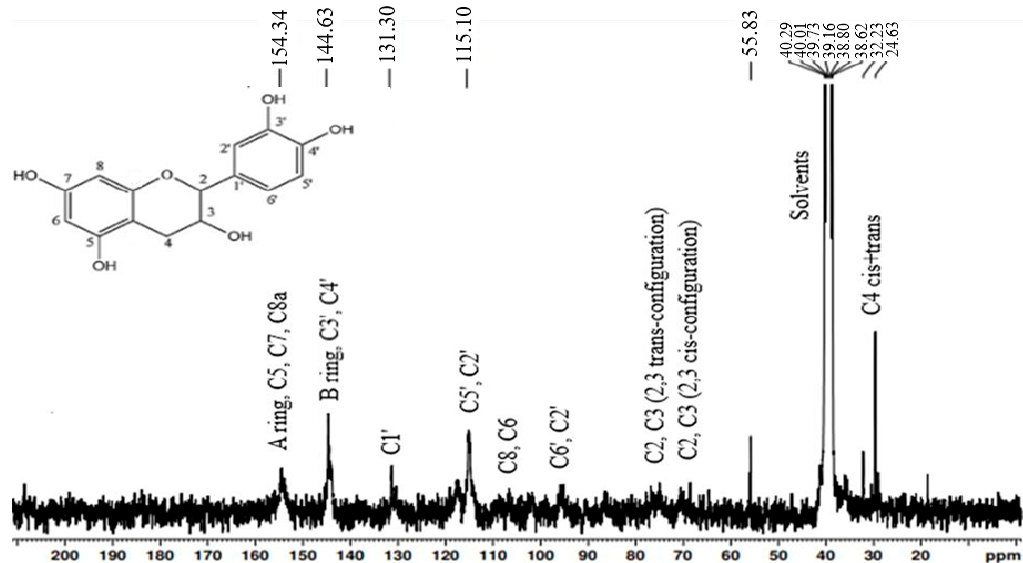
Figure 5. The 13 C-NMR spectrum of purified CTs from Alnus glutinosa bark.